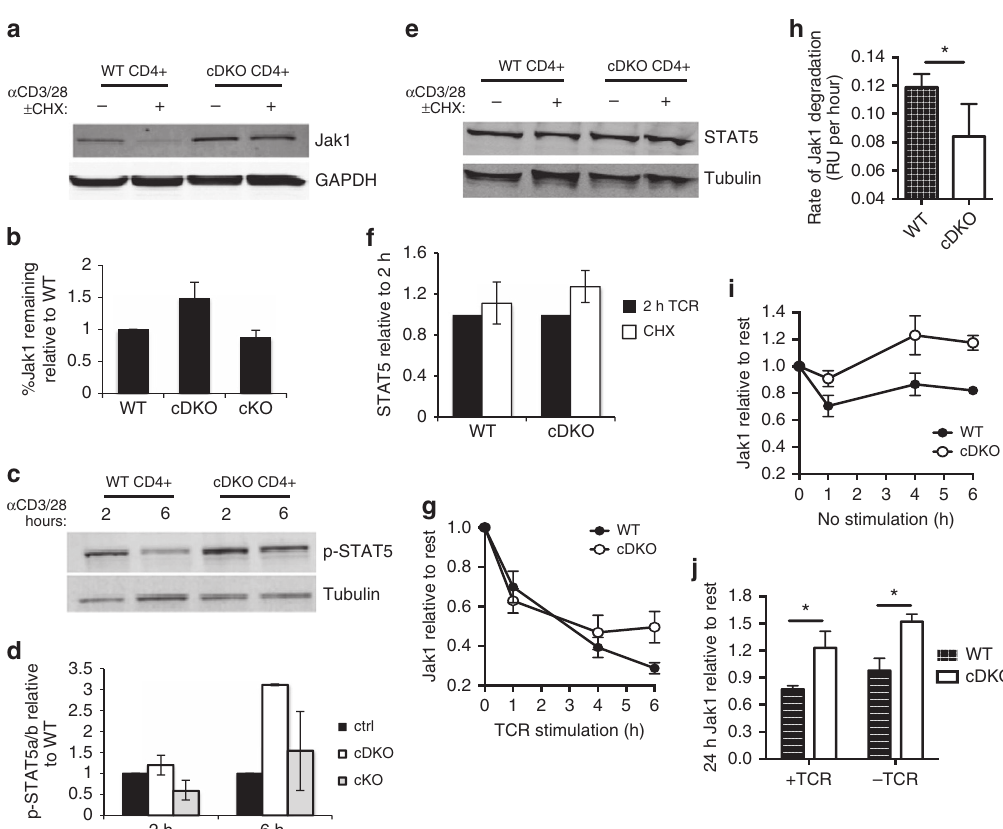
Figure 7 | Jak1 degradation is dependent on Ndfip1/Ndfip2. ( a – j ) Immunoblotting of restimulated WTand cDKO CD4 þ Tcells. ( a ) Cycloheximide was added 2h after CD3/CD28 stimulation; cells were then incubated for an additional 4h. ( b ) Level of Jak1 was normalized to GAPDH. The stability of Jak1 was determined by normalizing the percent Jak1 remaining in cDKO or cKO cells to the percent remaining in experiment-matched control cells. Data shown are average ± s.e.m. from three to five biologic replicates in more than three experiments. ( c , d ) p-STAT5 was quantified relative to tubulin. Relative levels of p-STAT5 in cDKO and cKO CD4 þ T cells were normalized to experiment-matched control cells at 2 and 6h of restimulation. Data shown is average ± s.e.m. for two biologic replicates. ( e , f ) Immunoblotting of total STAT5 in restimulated WTand cDKO CD4 þ Tcells. Cells were stimulated for 2h, and cycloheximide was added for an additional 2h of stimulation. ( f ) Level of STAT5 was normalized to GAPDH. The stability of STAT5 was determined by normalizing the relative STAT5 remaining after stimulation to the amount of STAT5 at 2h. Data shown are average ± s.e.m. from three biologic replicates. ( g – j ) Levels of Jak1, normalized to GAPDH, at various timepoints following restimulation of WTand cDKO CD4 þ Tcells relative to Jak1 in IL-2-rested cells at time 0. ( h ) Rate of Jak1 degradation in relative units per hour over 6h of stimulation. ( i , j ) Levels of Jak1, normalized to GAPDH, at various timepoints following rest in the absence of IL-2/TCR, of WT and cDKO CD4 þ T cells relative to Jak1 in IL-2-rested cells at time 0. ( j ) As in g and i , levels of Jak1, normalized to GAPDH, 24h ± TCR stimulation of WT and cDKO CD4 þ T cells relative to Jak1 in IL-2-rested cells at time 0. Data shown in g – j average